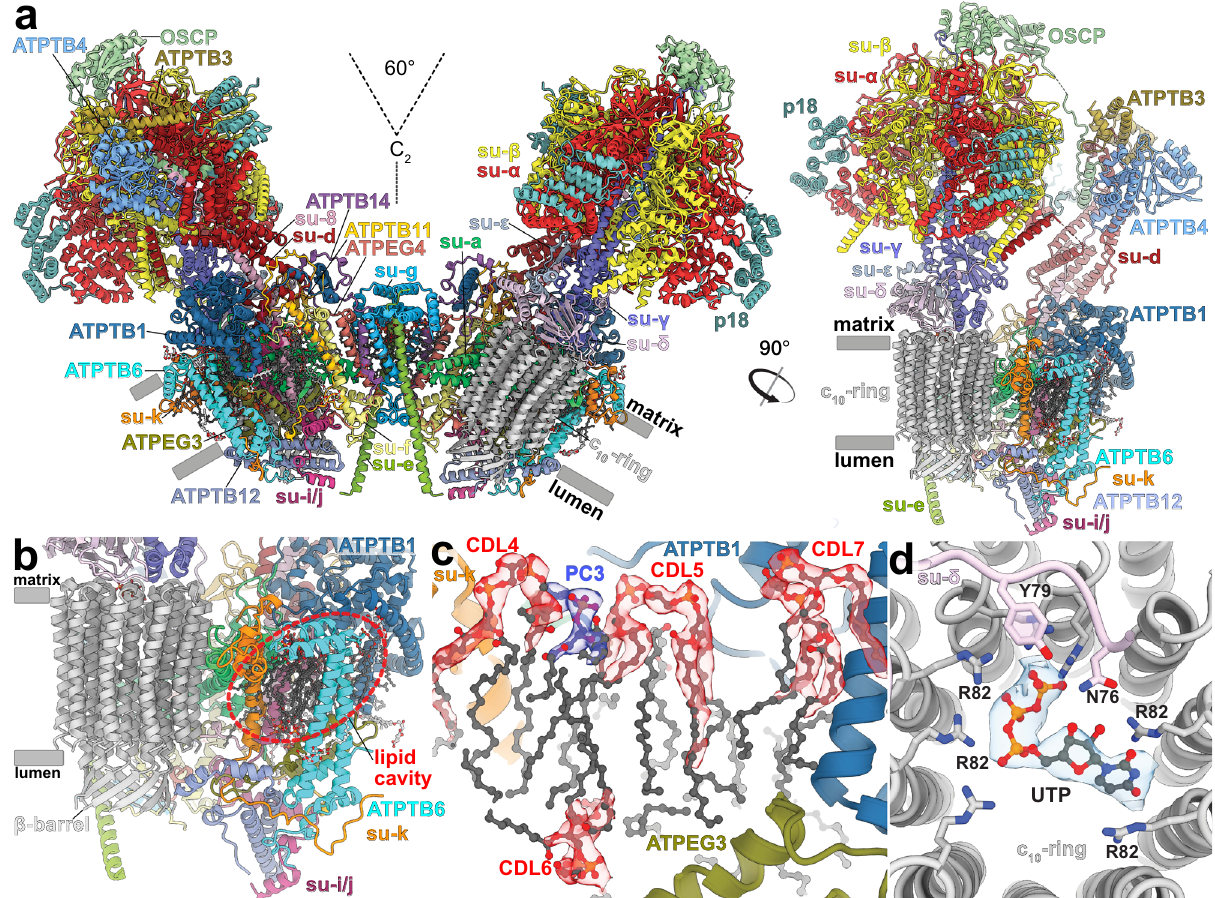
Fig.1|The T.brucei ATPsynthasestructurewithlipidsandligands.a Frontand side views of the composite model with both monomers in rotational state 1. The two F 1 / c 10 -ring complexes, each augmented by three copies of the phylum-speci fi c p18 subunit, are tied together at a 60°-angle. The membrane-bound F o region displays a unique architecture and is composed of both conserved and phylum- speci fi c subunits. b Side view of the F o region showing the lumenal interaction of